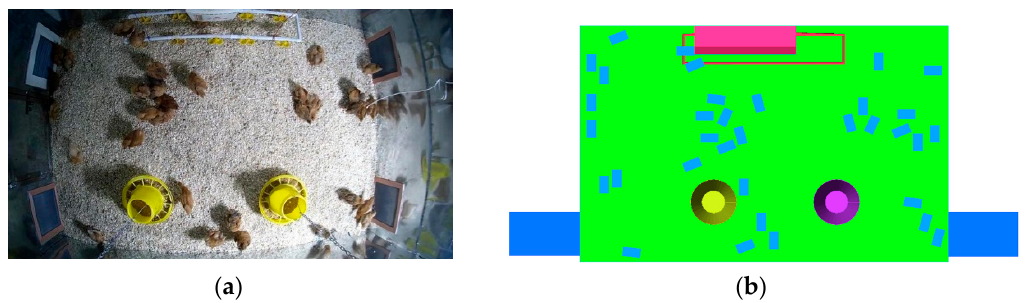
Figure 9. Experimental arrangement of the chamber with broilers was simulated by the block